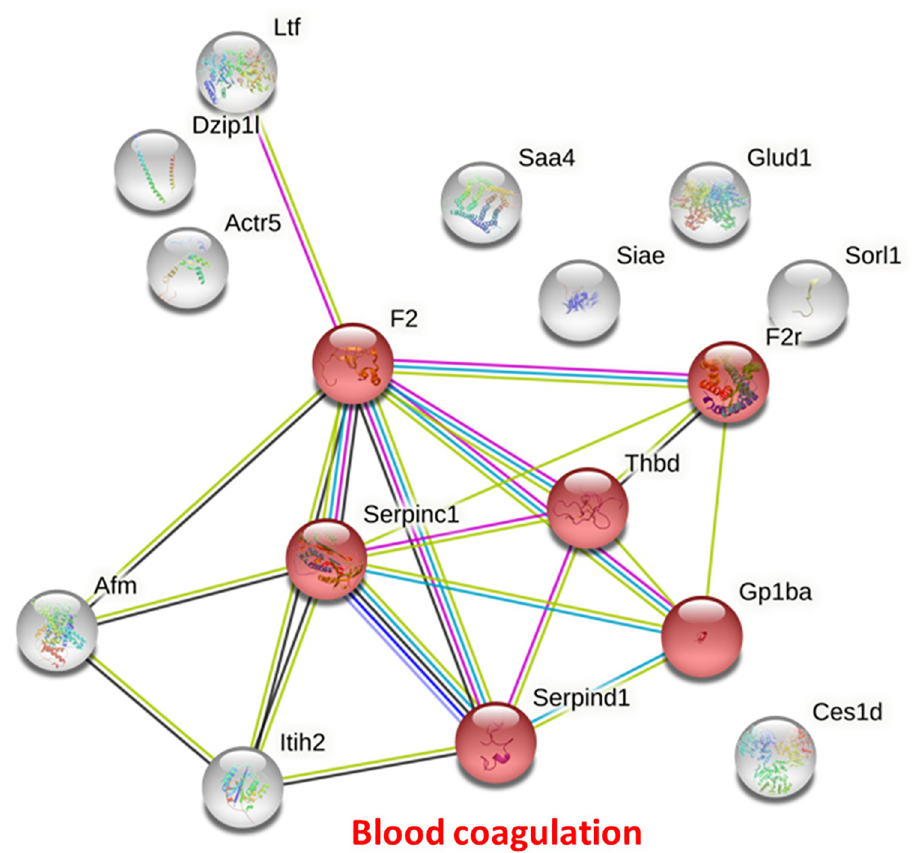
Fig 3. Protein–protein interactions of up-regulated mouse serum proteins 8 weeks post T . spiralis infection. Proteins identified by mass spectrometry were analyzed for their interactions using the STRING database. Red nodes represent proteins in the blood coagulation pathway which was predicted as the significant altered network after T . spiralis infection. The abbreviations for each protein are F2: Prothrombin, F2r: Thrombin receptor, Thbd: Thrombomodulin, Serpinc1: Serine/cysteine peptidase inhibitor clade c member 1, Serpind1: Serine/cysteine peptidase inhibitor clade d member 1, Gp1ba: Platelet